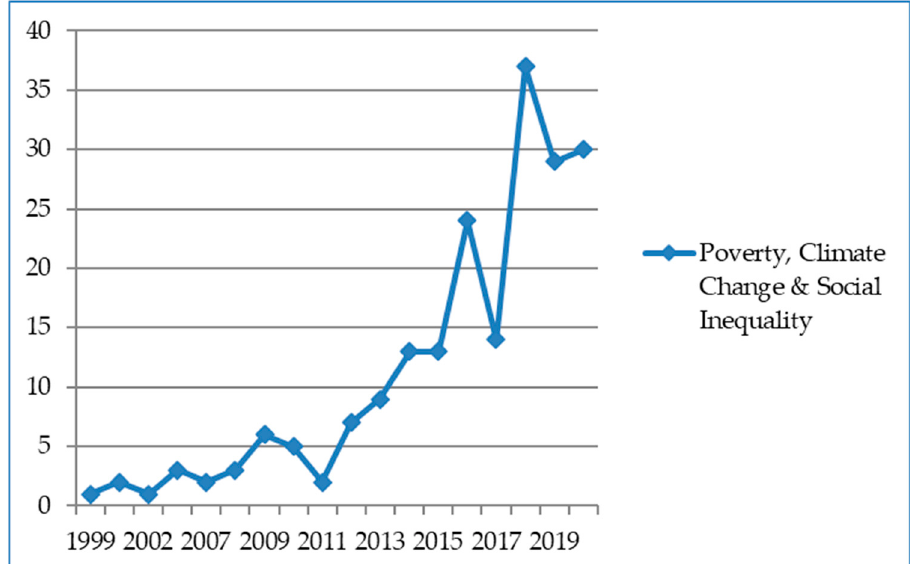
Figure 2. Number of publications per year on poverty, climate change, and social inequality.